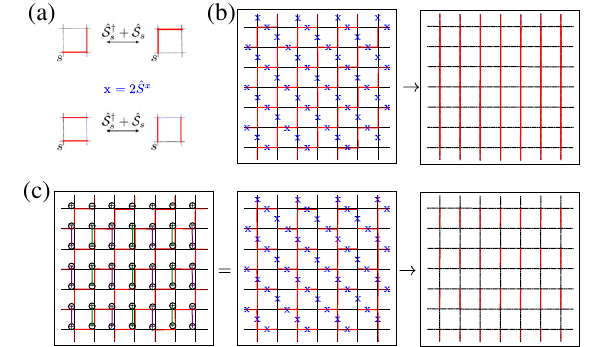
FIG. 5. Relation between gauge magnets and the quantum dimer model. (a) By reversing the spins of the links at the bottom- left (or at the top-right) corner of the plaquette, the plaquette operator becomes a dimer move; see Eq. (A1). (b) In the dimer basis, obtained by reversing the spins of the links at the bottom- left corner of the odd plaquettes, the fully flippable background j Ω i appears as a columnar state. (c) The physical states of the quantum dimer model are obtained for a staggered distribution of − 1 Þ s . Such states can be constructed by static charges, Q s ¼ ð applying the plaquette operator on the maximally flippable background depicted in the figure. It is obtained by super- imposing a string covering associated to the charges on j Ω i . Because of the charges, only half of the plaquettes are